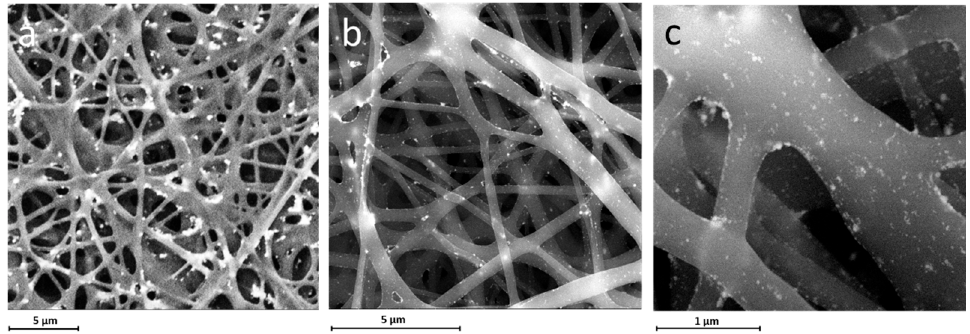
Figure 5. SEM images of AgNP-containing P(3HB)/P(3HO- co -3HD) nanofibers obtained by protocol 3 with magnifications ( a ) ×12,000, ( b ) ×25,000, ( c ) ×100,000 exhibit the uniform and dense immobilization of AgNPs on the nanofibers.